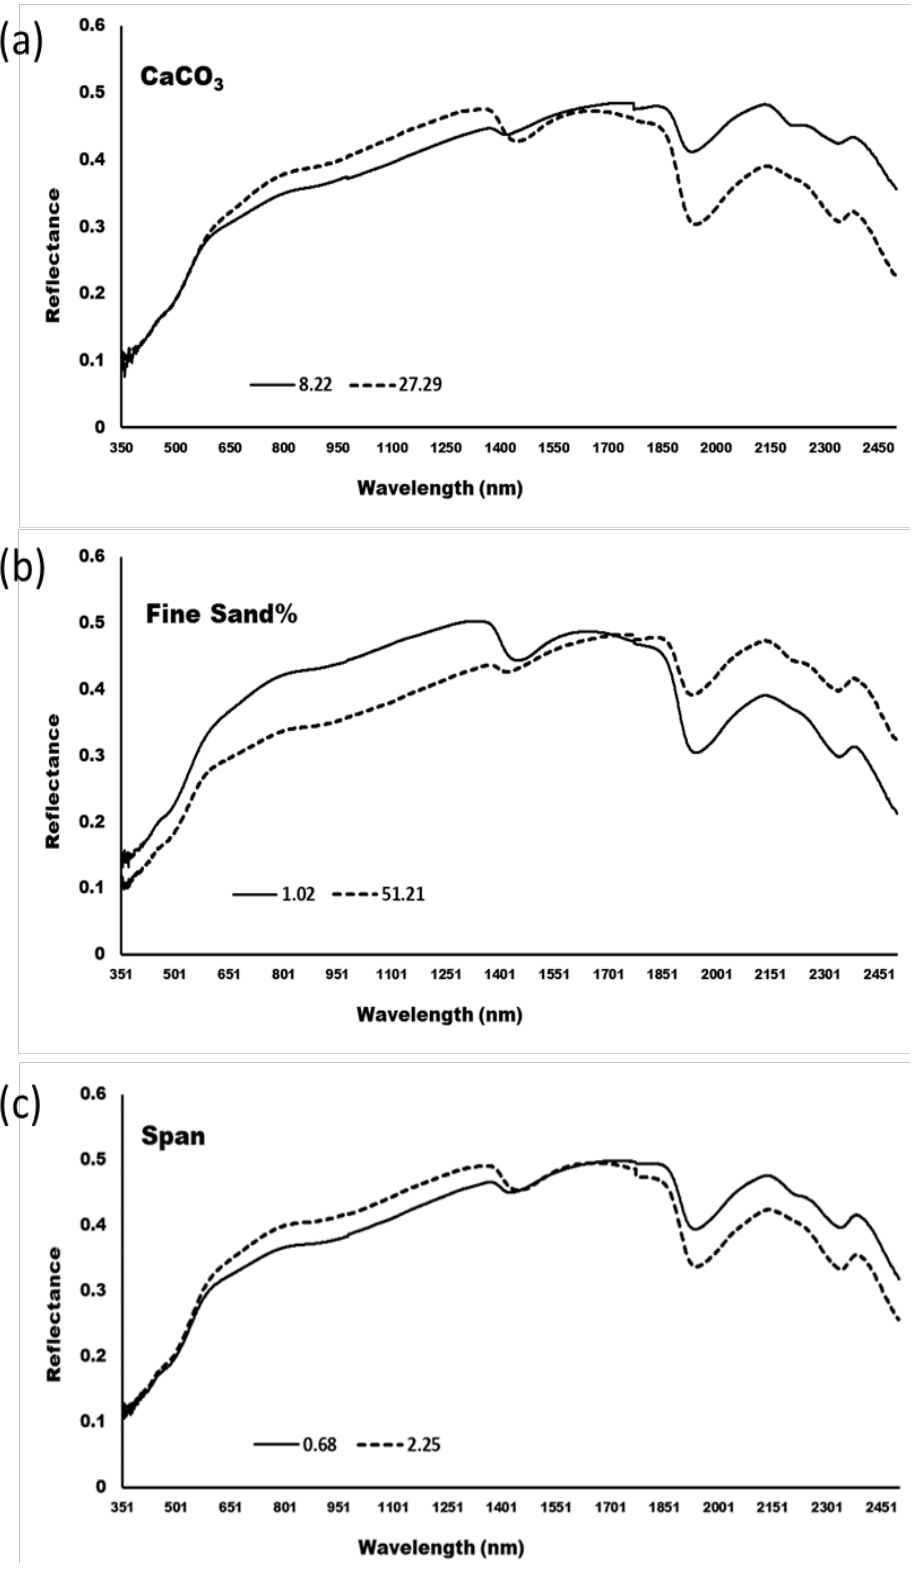
Figure 10. Examples of the spectral signature of individual sediment samples with the greatest range of ( a ) CaCO 3 values (highest: #133, lowest: #98); ( b ) span values (highest: #61, lowest #139); and ( c ) fine sand percentage (highest #52, lowest #90).